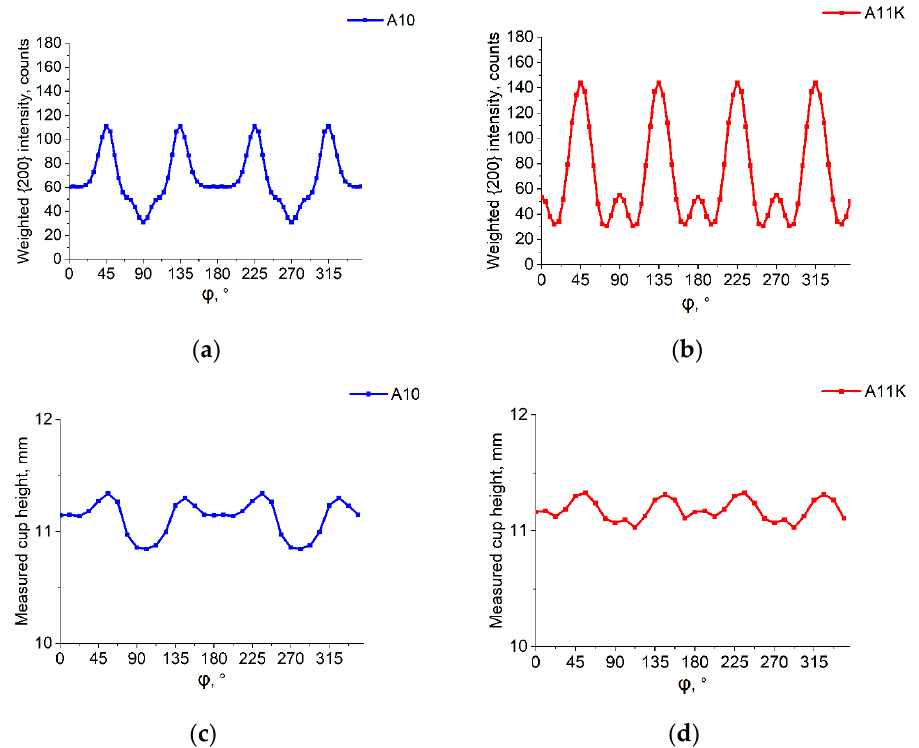
Figure 6. Cup heights of the samples cold-rolled in 12 steps. ( a ) Predicted relative cup height of the unidirectionally rolled sample; ( b ) predicted relative cup height of the cross-rolled sample; ( c ) measured cup height of the unidirectionally rolled sample; ( d ) measured cup height of the cross-rolled sample.